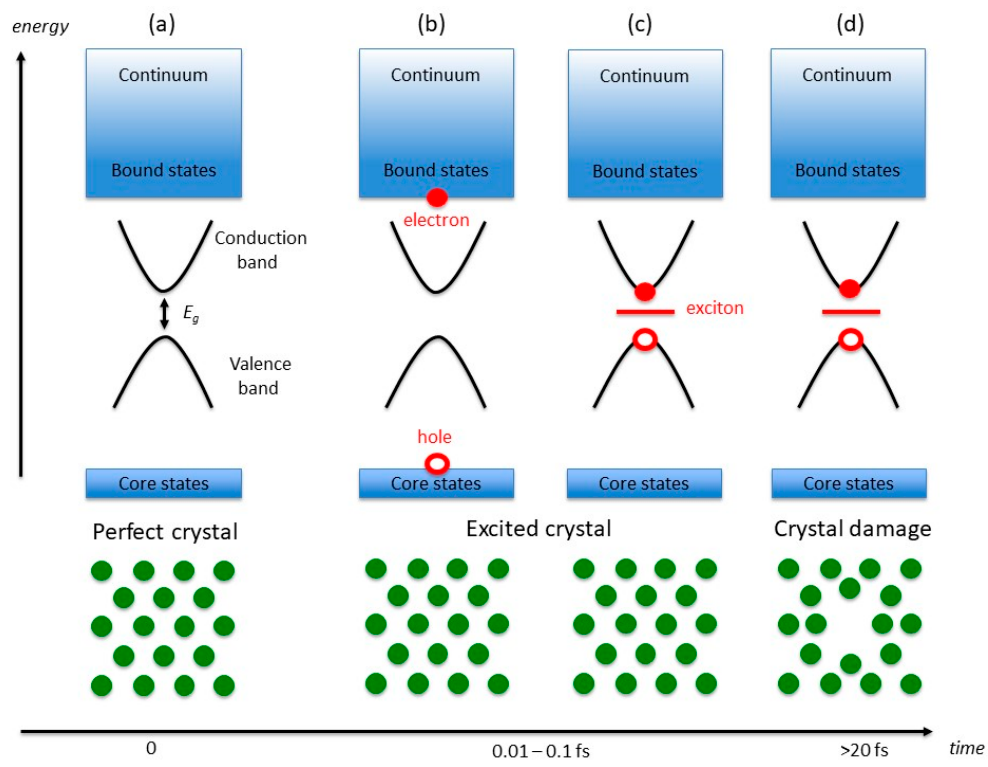
Figure 1. Electronic energy diagram (top) and atomic position schematic (bottom). The scheme describes how changes in both the crystal electronic states and atomic positions evolve as X-rays traverse an insulating crystal. Of particular relevance is the band gap E g (0.1–10 eV) between the most energetic electron at the top of the valence band and the energy of a virtual state at the bottom of the conduction band. Initially ( a ) all atoms lie in a periodic structure and the electrons populate core and valence states, up to the Fermi energy. As some X-ray photons are absorbed, electrons are excited from core states to bound virtual states ( b ), and counterpart holes are created in the core states. The excited electrons and holes can form bound excitons ( c ). If the lifetime of the exciton pair is sufficiently long (10–100 fs or more), the atomic structure relaxes to screen the exciton ( d ), which, macroscopically, determines global changes in the crystalline structure and loss of diffracted intensity.